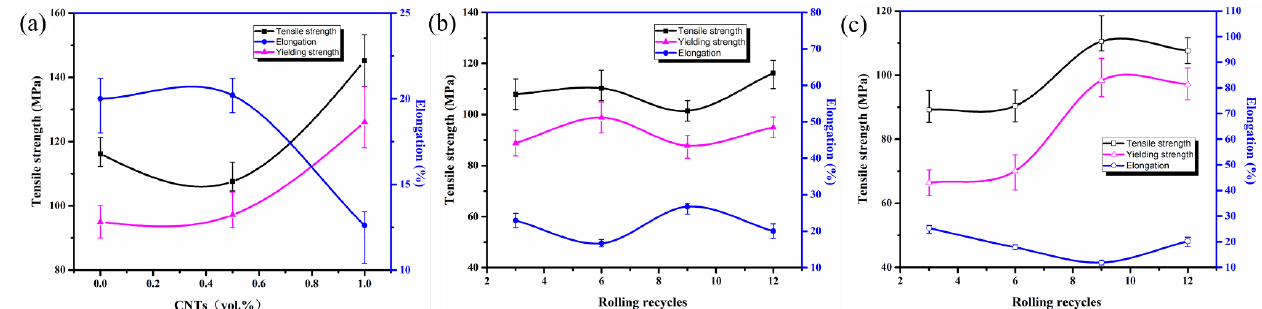
Figure 4. Mechanical properties of Al/CNTs nanocomposites with 0, 0.5 and 1.0 vol.% CNTs after 12 ARB cycles ( a ) and Al with 0 ( b ), 0.5 ( c ) vol.% CNTs rolling different cycles.